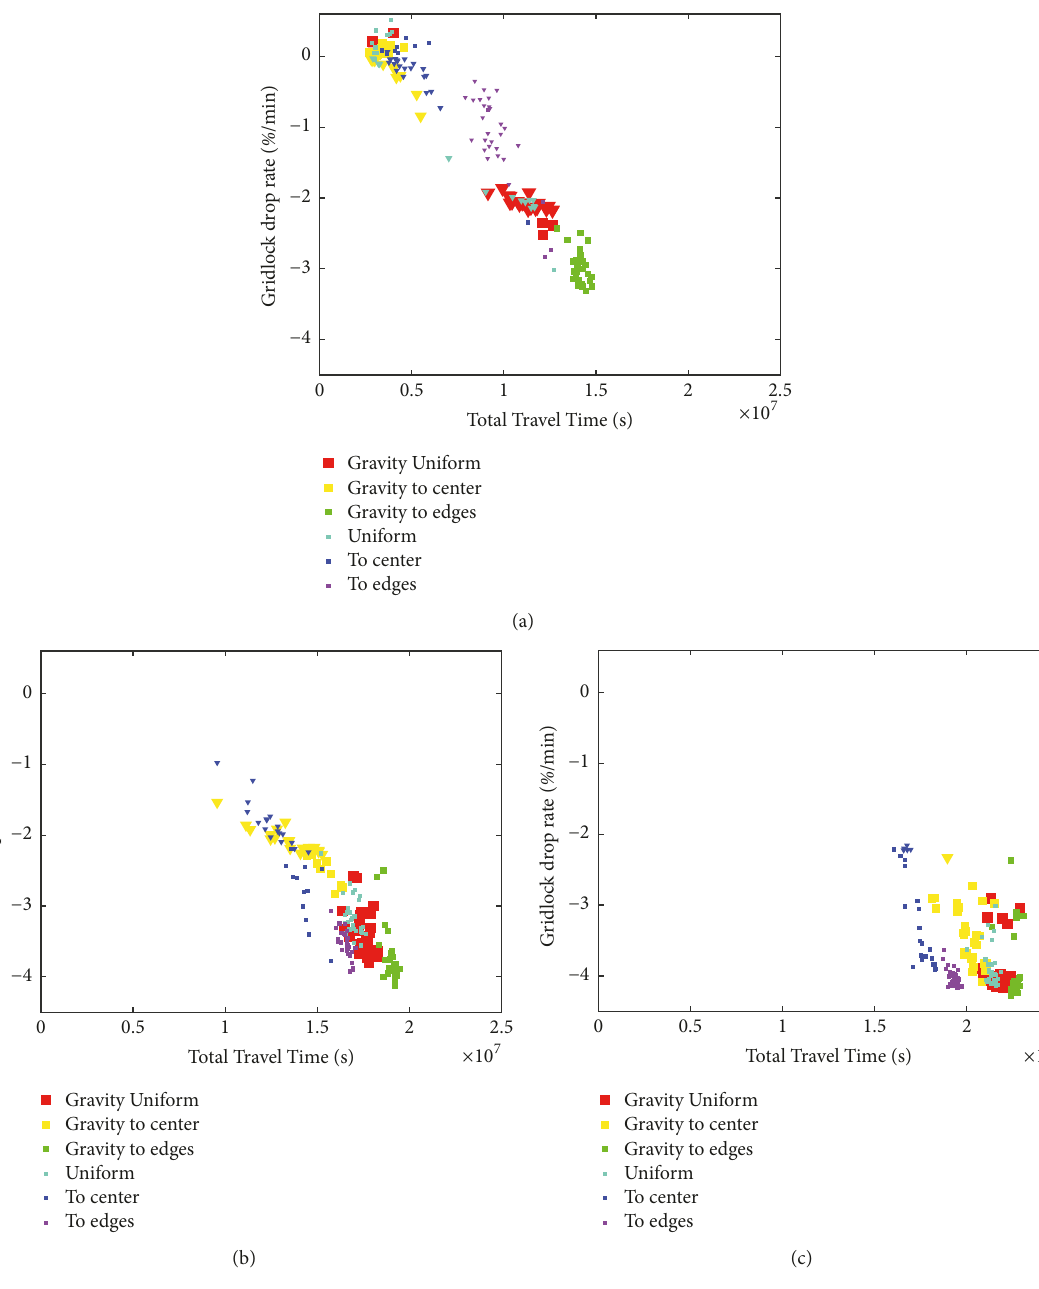
Figure 8: Gridlock drop rate colored by pattern. (a) Demand level 4, (b) demand level 5, and (c) demand level 6.